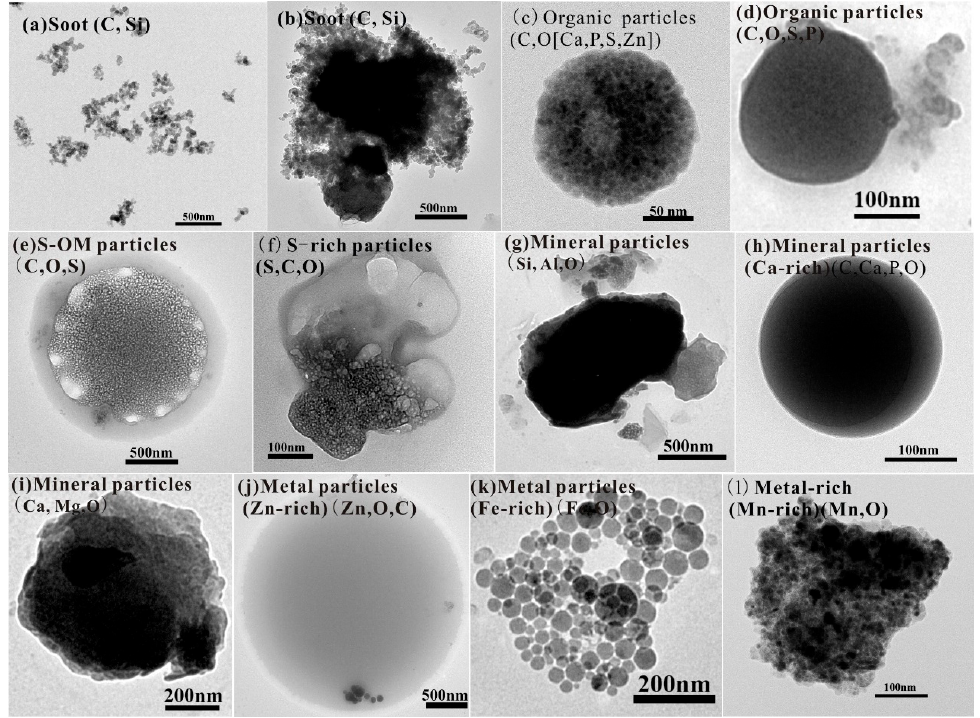
Figure 2. TEM images of individual particles at a roadside site ( a , b ): soot particles; ( c , d ): organic particles; ( e ): S-OM particles; ( f ): S-rich particles; ( g – i ): mineral particles; ( j – l ): metal particles). Mixture particles were mainly mixed with S-rich, soot, organic, mineral, or metal particles, with a nearly spherical shape or a core-shell structure (Figure 3). The majority of mixtures were S-OM particles and S-inclusion particles. S-OM particles were S-rich ones with secondary organic components and had core-shell structures with a sulfate core and OM coating. The ion maps of particles at the roadside site from the NanoSIMS showed 12 C 14 N − signals in the coating and 32 S 2 − signals in the core (Figure 4). This underlines that the coating of particles was by an organic component, and the core of the particles was made up of a sulfate component. S-inclusion particles were S-rich, with inclusions of soot, minerals, or metals (Figure 3).